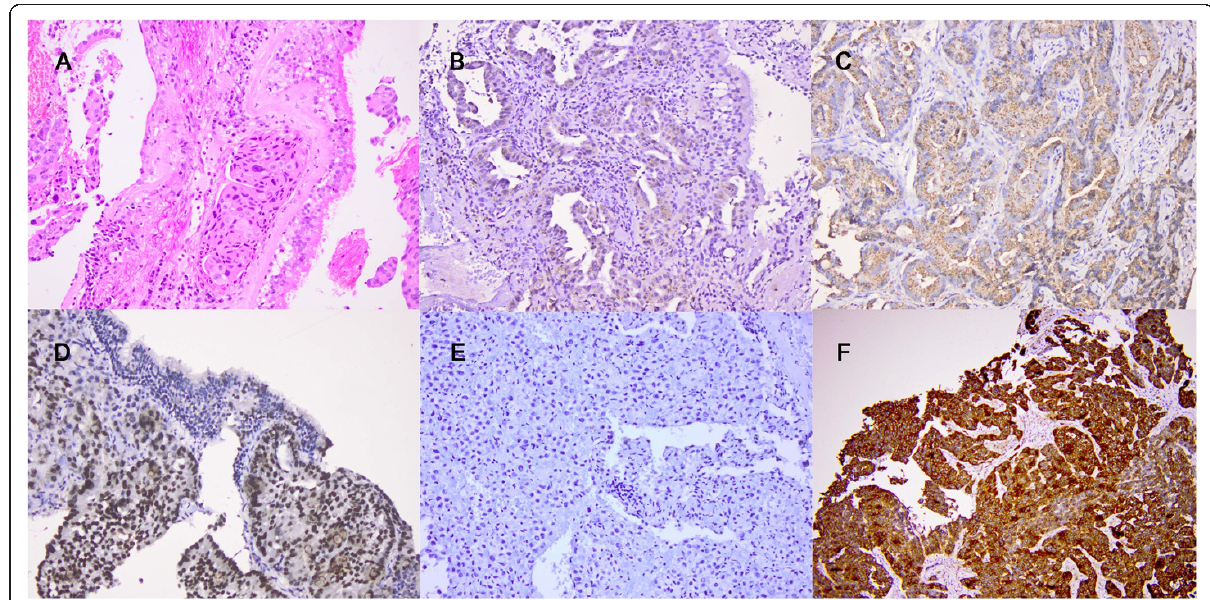
Figure 1 Expression of TTF-1, Napsin A and IMP3 in lung adenocarcinoma. A Tumor tissue infiltrates bronchal mucosa, B Nuclei of malignant cells are positive to TTF-1, C Weak cytoplasmatic granular positivity to Napsin A. D Strong granular cytoplasmatic positivity to Napsin A. E Negative expression od IMP3, F positive expression of IMP3